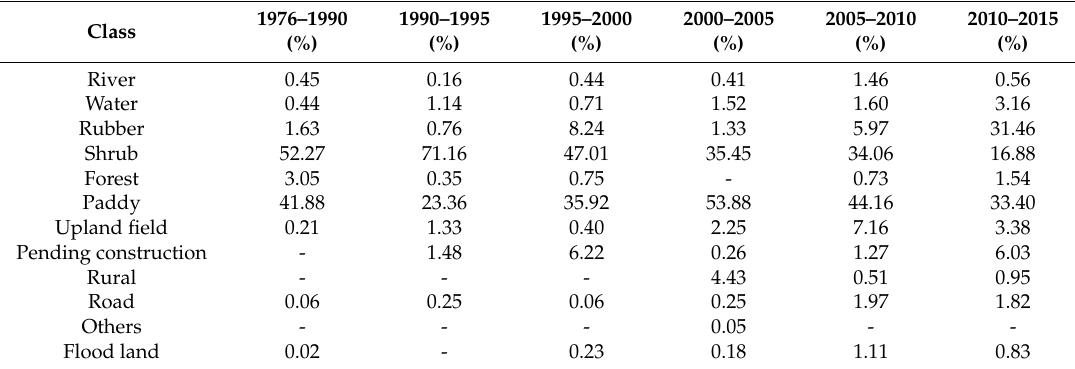
Table 4. Contribution rate matrix of urban expansion from 1976 to